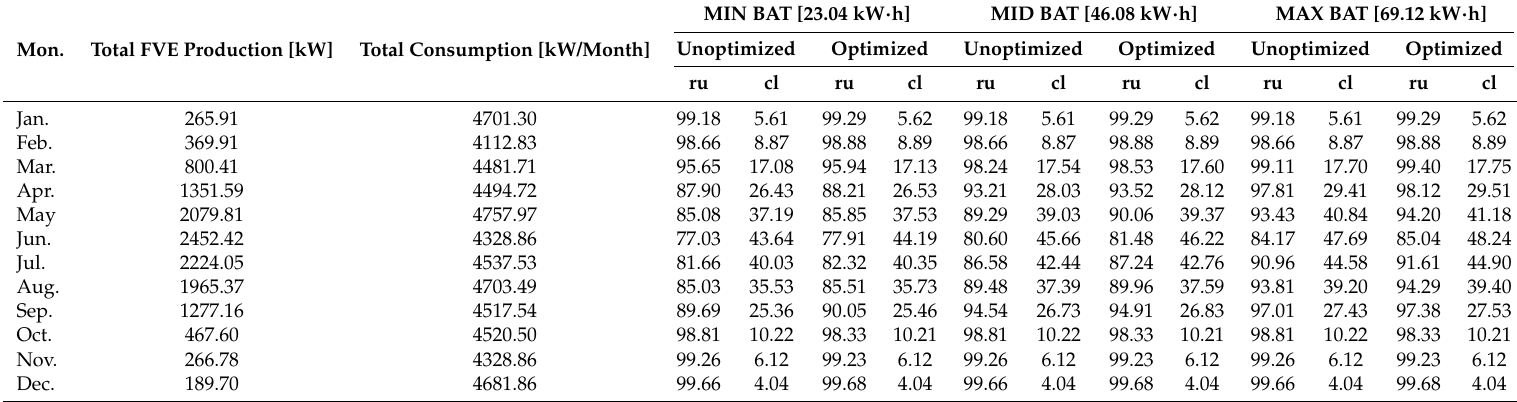
Table 4. Energy savings acquired for different system configurations having optimized and unoptimized simulations. Shortcut ’ru’ means percentage of renewable energy used and ’cl’ means the percentage of covered load by RES. Outcomes in this table were computed on lower charging scenario—not taking the current battery balance in car.